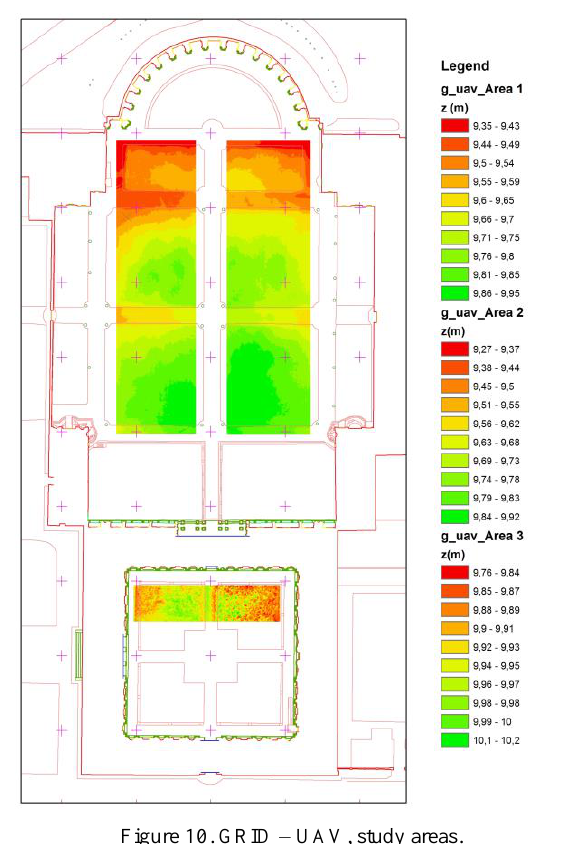
Figure 12. GRID – TLS, study areas.